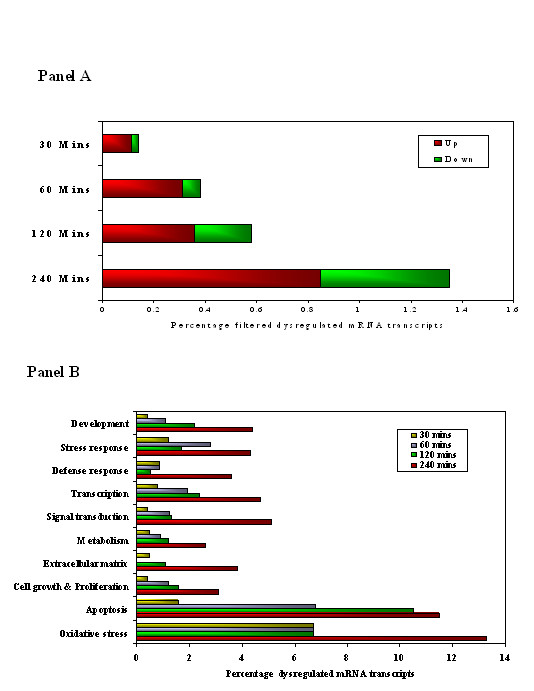
Gene expression changes in osteoblasts exposed to dexamethasone. Comparisons were made between control and 30, 60, 120 and 240 minute time exposures to dexamethasone. Panel A shows a bar graph representing the percentage of genes represented on the microarray that were found to be significantly altered at each time point. T1 = control, T2 = 30 mins, T3 = 60 mins, T4 = 120 mins and T5 = 240 mins dexamethasone exposure. All significantly dysregulated genes (SLR < -0.6 & SLR > 0.6) were used in classification searched. Panel B shows bar chart describing the dysregulated transcripts, from each family that were found to be significantly changed at each time point. Panel